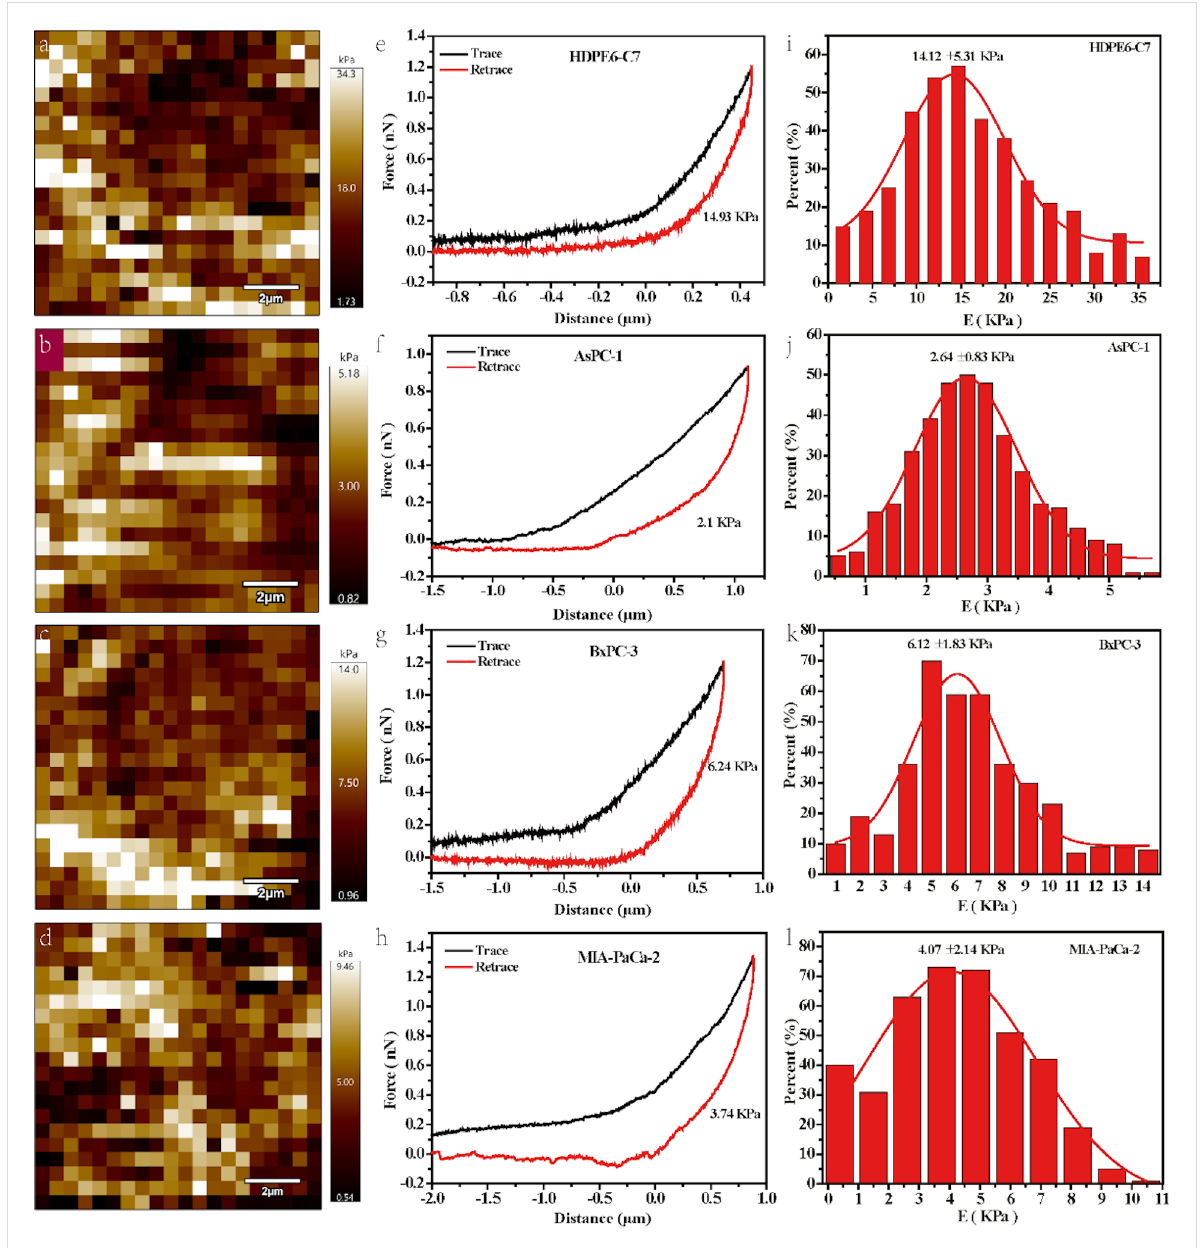
Figure 3: Nanomechanical mapping, FDCs, and corresponding Young's modulus distribution of (a) HDPE6-C7, (b) AsPC-1, (c) BxPC-3, and (d) MIA-